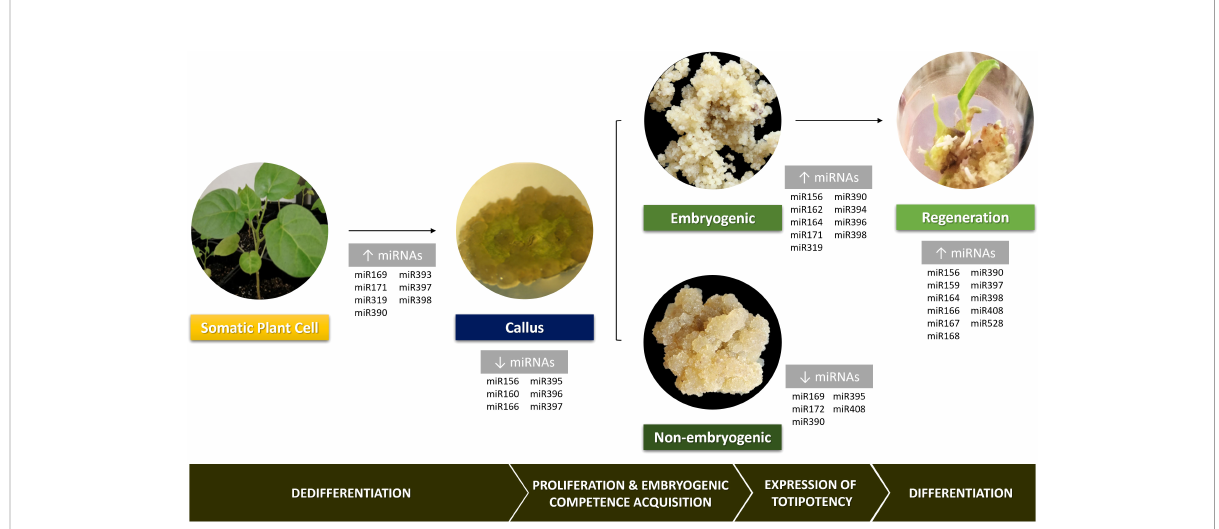
FIGURE 2 General overview of the involvement of several miRNAs families in various stages of plant cell reprogramming during in vitro indirect somatic embryogenesis. Pictures of Solanum beataceum illustrate key stages of the regeneration